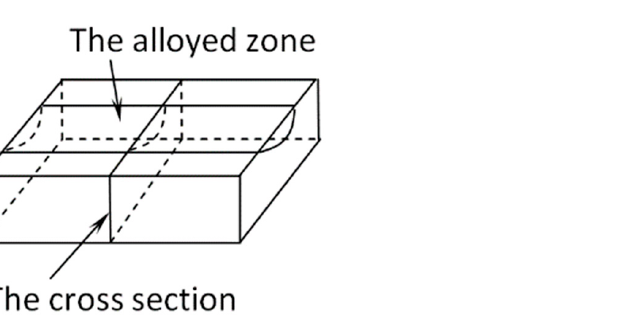
Figure 3. Scheme of the sample after the laser alloying with the cross-sectional plane marked for testing.